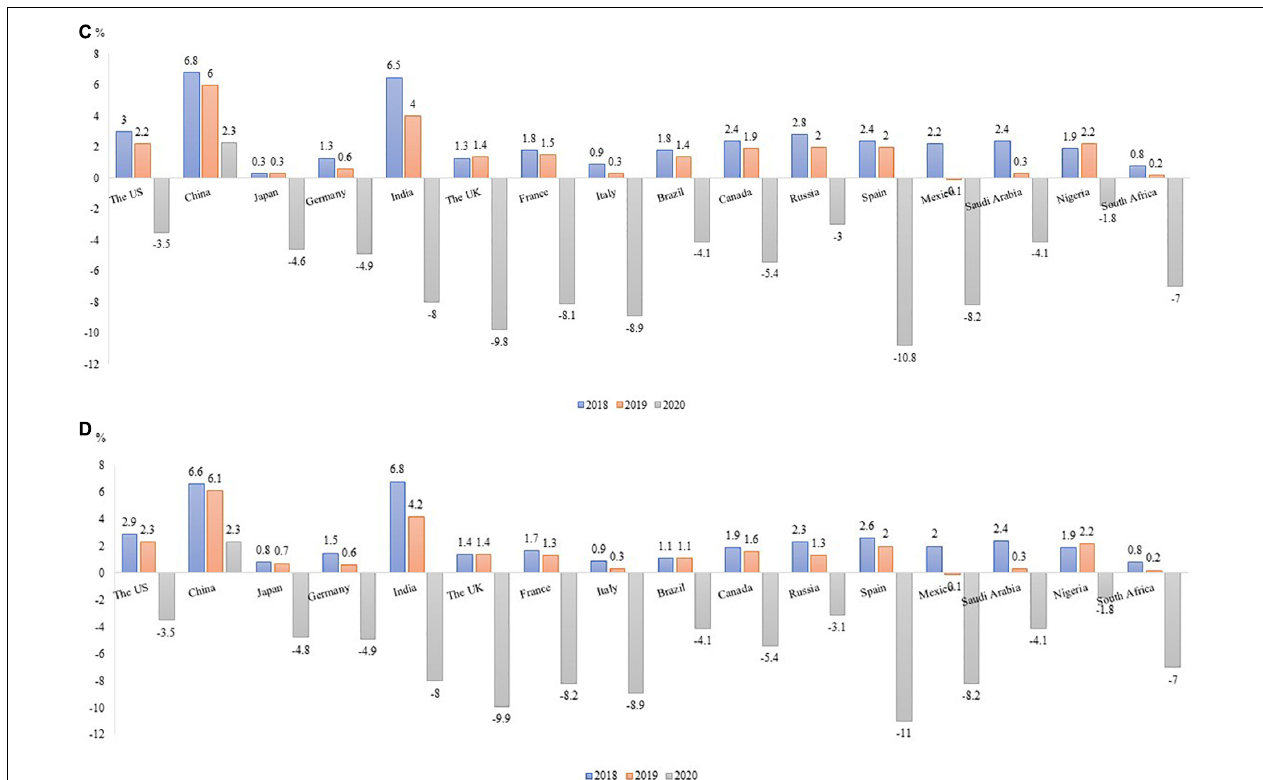
FIGURE 1 | (A) GDP Changes from 2016 to 2020 (World Bank). Based on data from the World Bank database, the change in GDP of the world’s major economies from 2016 to 2020 is calculated in current US dollars (August 21, 2021). The World Bank database lacks the GDP data of Japan in 2020. The data here comes from the Statistics of the Japanese Cabinet Office and is converted to current US dollars (Japanese Cabinet Office: https://www.esri.cao.go.jp/jp/sna/menu.html). (B) GDP Changes from 2016 to 2020 (IMF). Based on data from International Monetary Fund (IMF) database, the change in GDP of the world’s major economies from 2016 to 2020 is calculated in current US dollars (September 8, 2021). The IMF database lacks 2020 GDP data for China, India, Russia and Nigeria, which are derived from the World Bank database and converted to current US dollars. (C) Changes in annual GDP growth (%) rates in major economies (World Bank). Based on data from the World Bank database. The World Bank database lacks the GDP data of Japan in 2020. The data here comes from the Statistics of the Japanese Cabinet Office (Japanese Cabinet Office: https://www.esri.cao.go.jp/jp/sna/menu.html). (D) Changes in annual GDP growth (%) rates in major economies